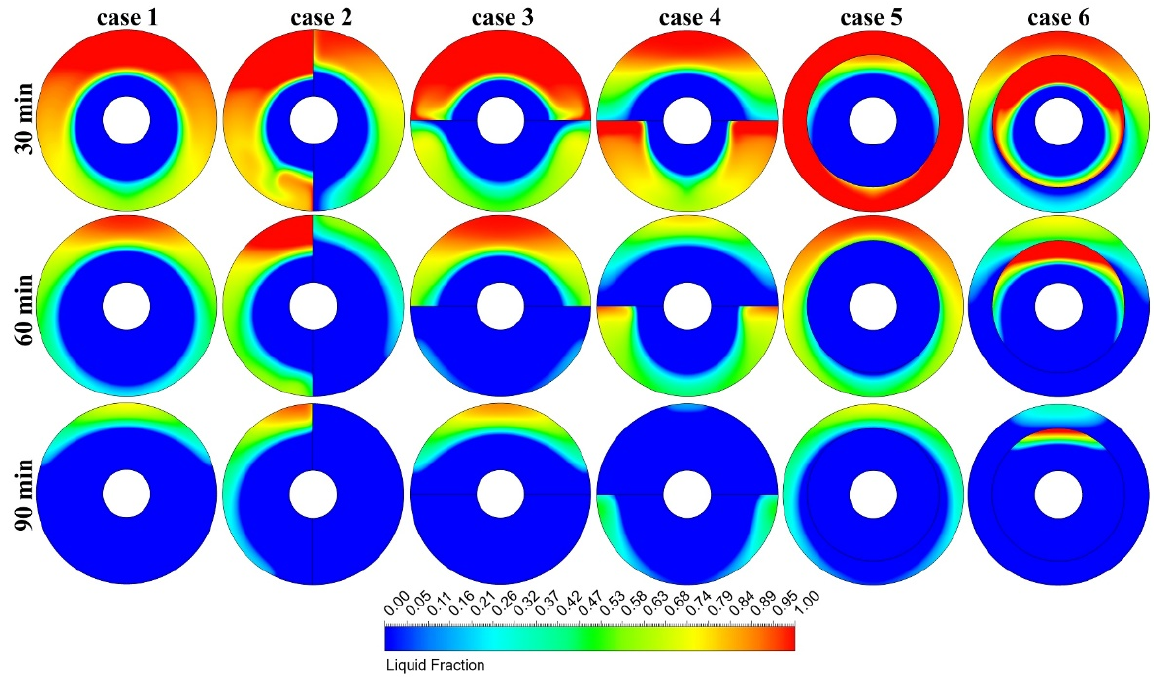
Figure 5. Liquid-fraction contours of the studied cases at different time-stages.